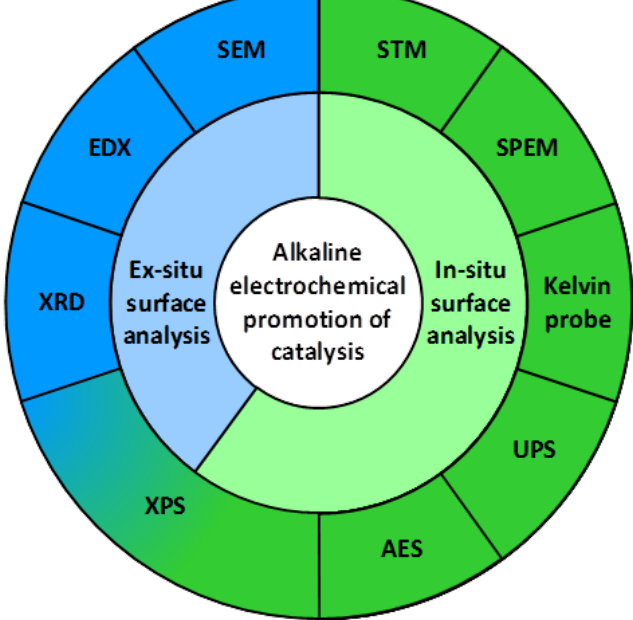
Figure 2. Scheme of the different surface analysis techniques used for investigating alkaline Electrochemical Promotion effect. Electrochemical Promotion